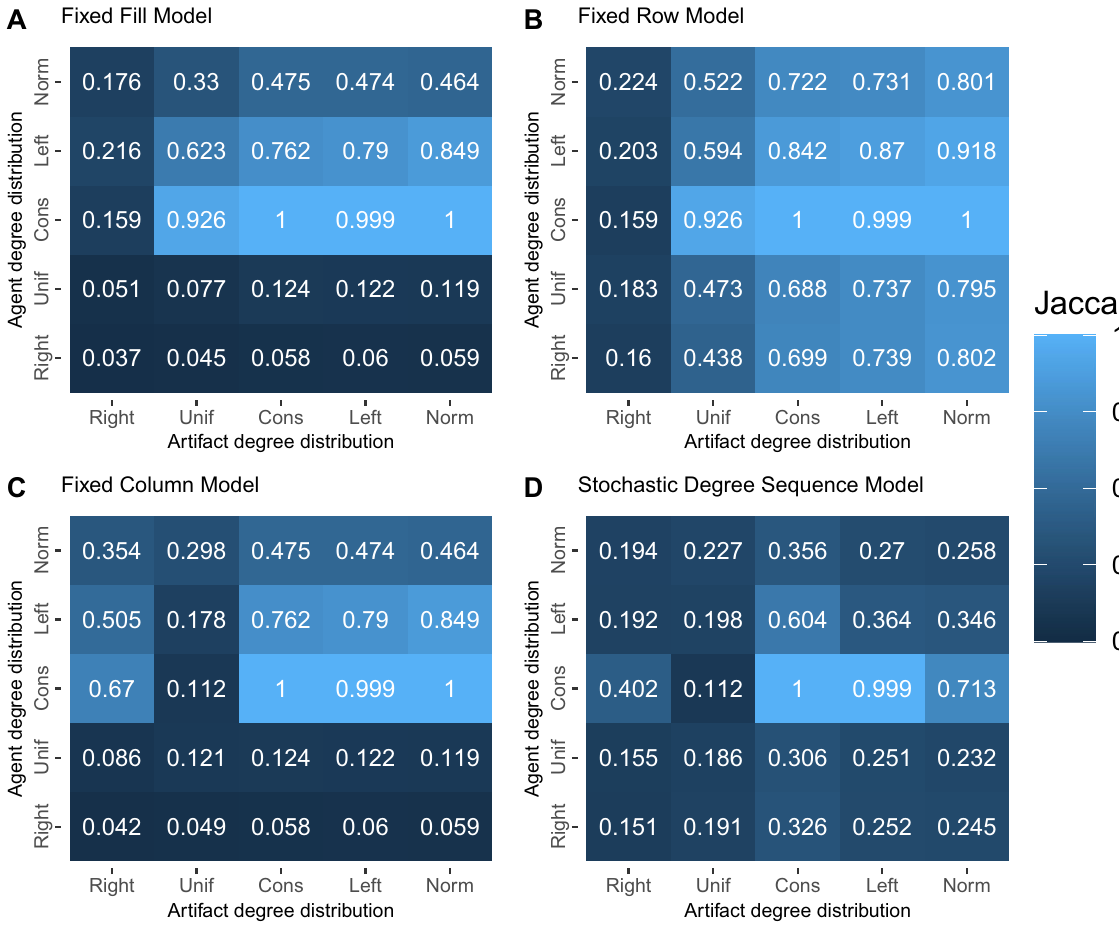
Figure 3. Jaccard similarity of a backbone extracted at α = 0.05 using the Fixed Degree Sequence Model and a backbone extracted using ( A ) the Fixed Fill Model, ( B ) Fixed Row Model, ( C ) Fixed Column Model, ( D ) Stochastic Degree Sequence Model. Each cell represents the mean over 100 instances of a 100 × 100 bipartite network with given agent and artifact degree